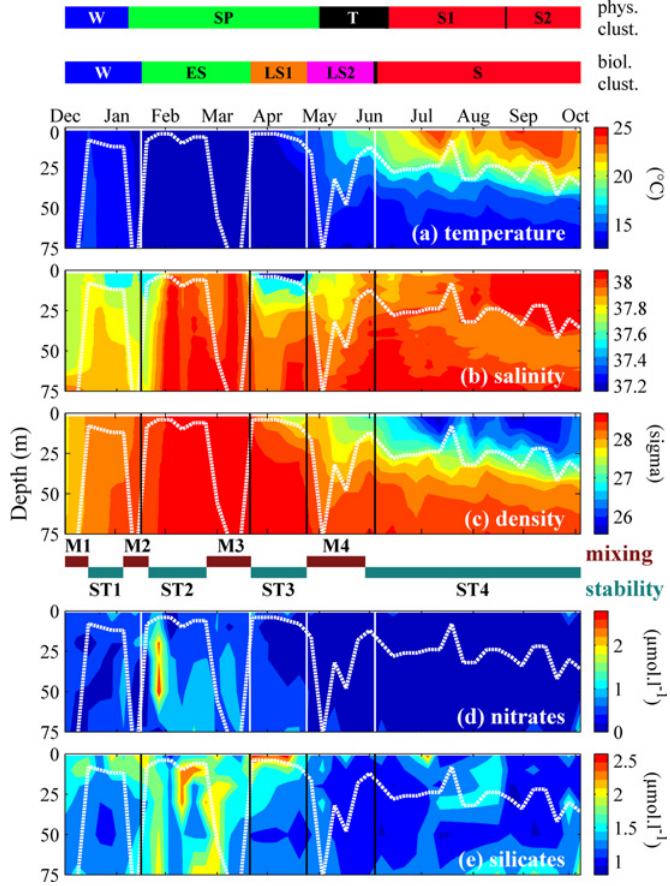
Fig 3. Variations of environmental conditions at the sampling station between December 2010 and October 2011. The two coloured bars at the top represent the duration of the different clusters based on the two sets of variables, i . e . physical (W = winter, SP = spring, T = transition, S1 = summer 1, S2 = summer 2) and biological (W = winter, ES = early spring, LS1 = late spring 1, LS2 = Late Spring 2, S = summer) (the clustering analyses are detailed in Fig. 4). Panels: (a) temperature, (b) salinity, (c) water density with (indicated below) periods of mixing (M1 – M4) and stability (ST1-ST4), (d) nitrate, and (e) silicate. The white dotted curve repeated in all panels represents the depth of the maximum density gradient (pycnocline) estimated from the Brunt-Va ï sälä frequency. The vertical lines represent the limits of clusters based on biological variables ( i . e . PEC time